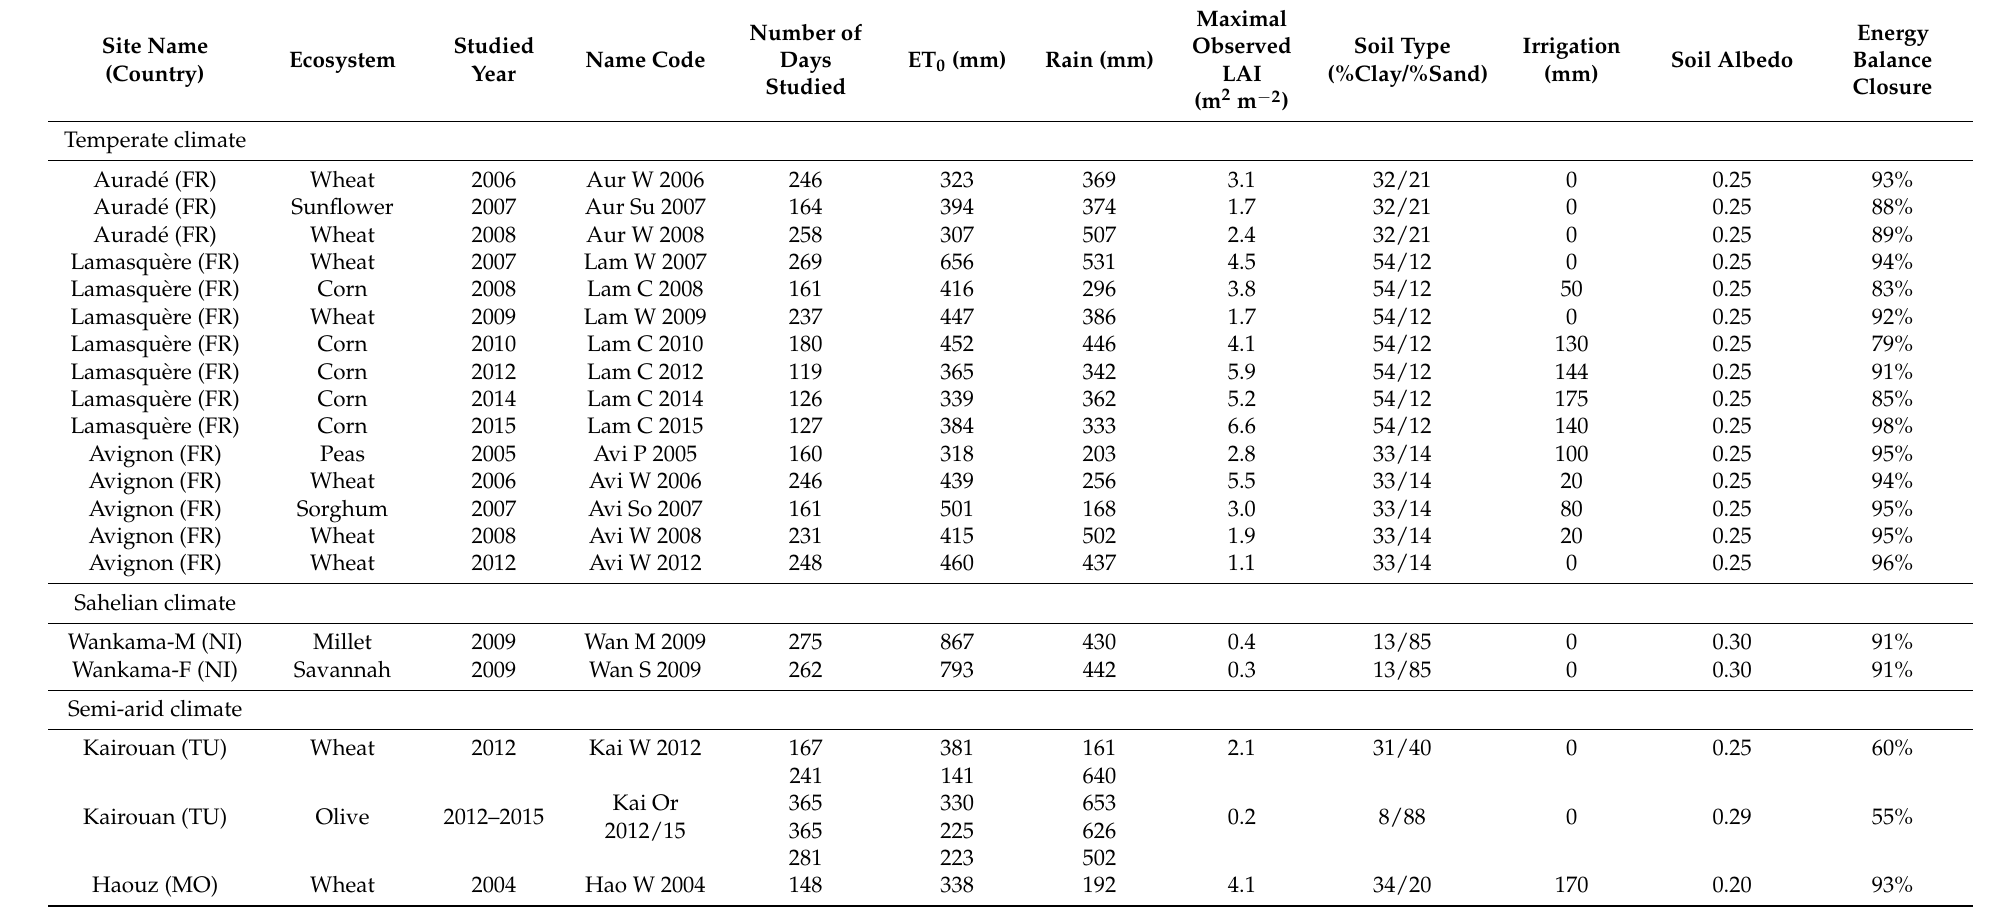
Table 1. Main characteristics of the